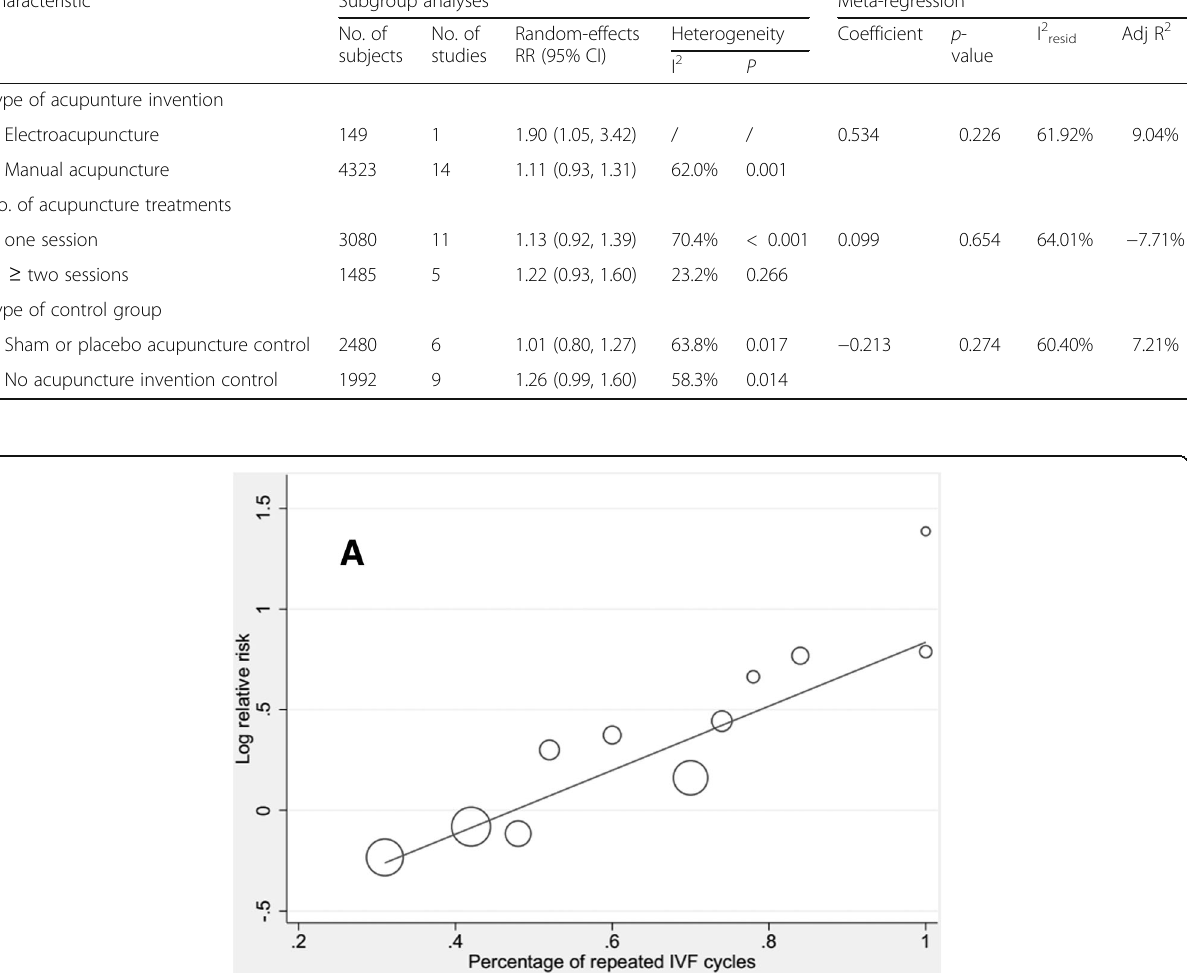
Table 3 The results of meta-regression subgroup analyses for primary outcomes (Continued) Characteristic